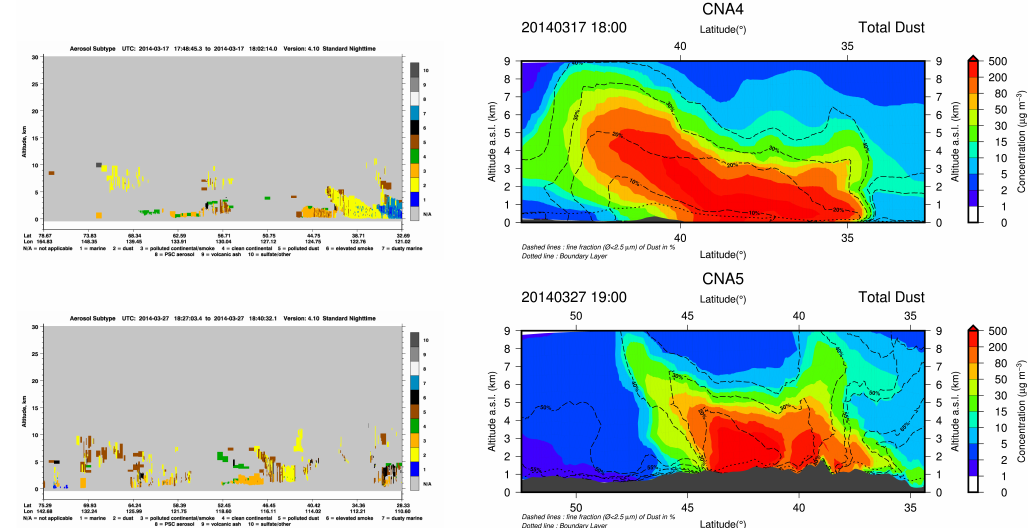
Figure 24. Cross section of CHIMERE dust concentrations ( right ) for two dates zoomed over the highest values area versus the corresponding CALIPSO qualitative data ( left ) showing in yellow the dust load and in orange the polluted dust, for the CALIPSO trajectories CNA4 ( top ) and CNA5 ( bottom ) as reported in Figure 2. The dotted line represents the height of the boundary layer, the dashed lines represent the fraction of fine dust in